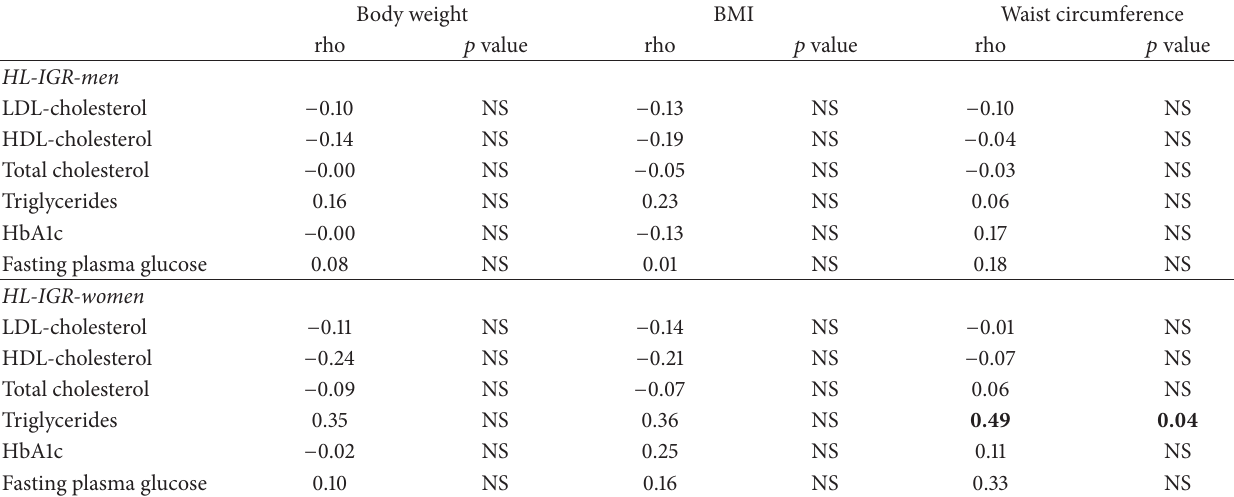
Table 4: Correlation analysis of parameters of body composition with cardiovascular and metabolic characteristics divided by sex in HL-